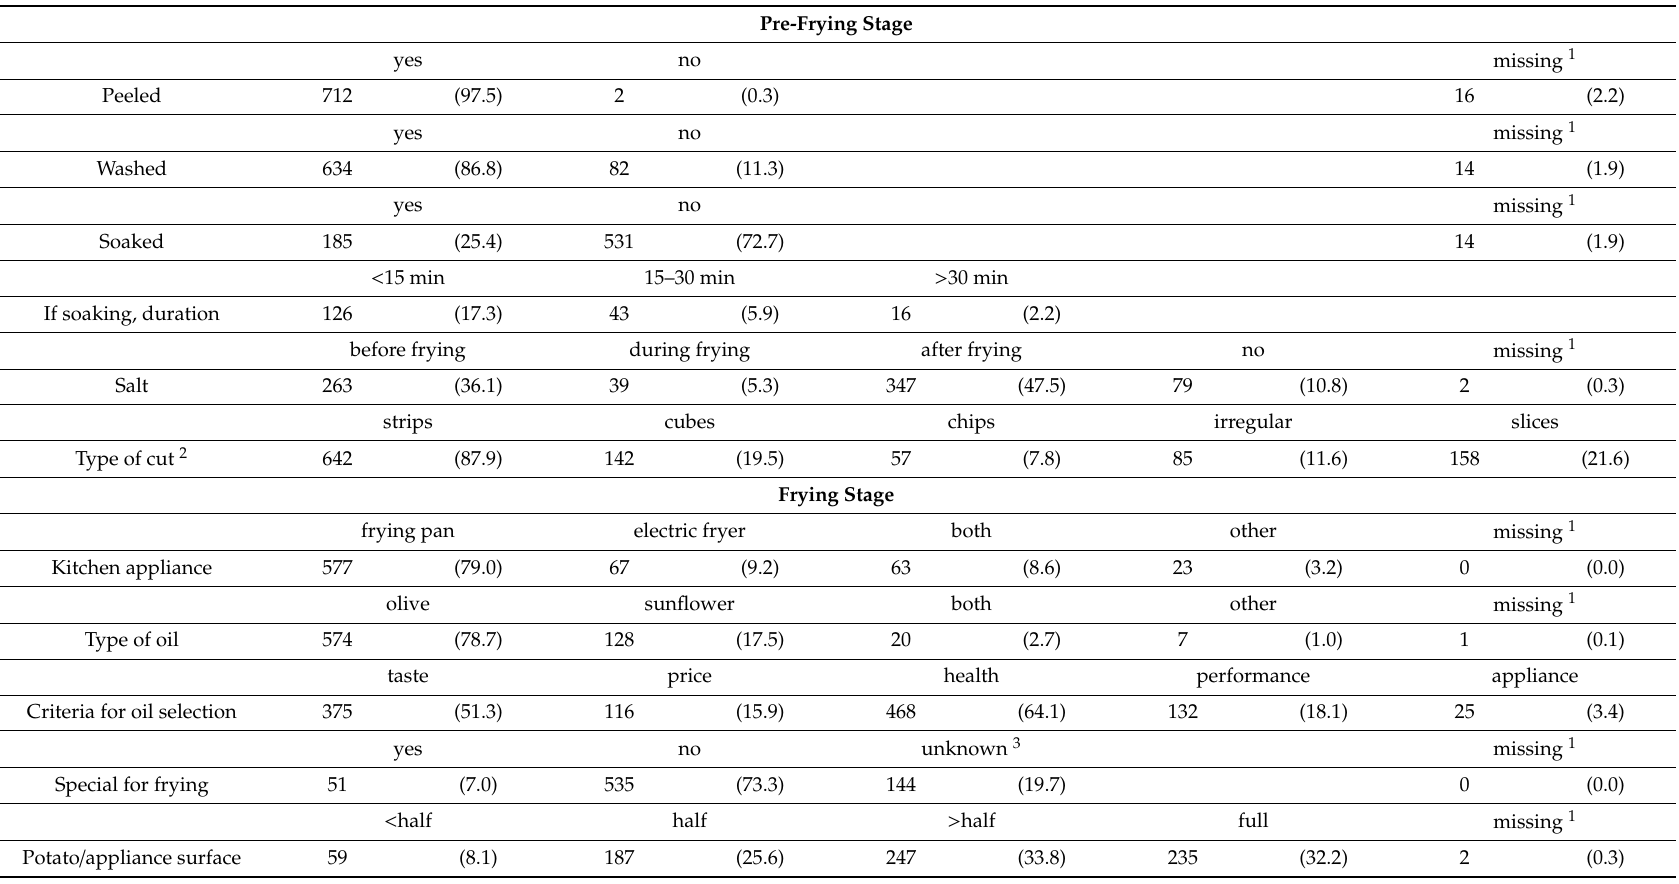
Table 3. Habits for frying potatoes in a Spanish population (number of cases,